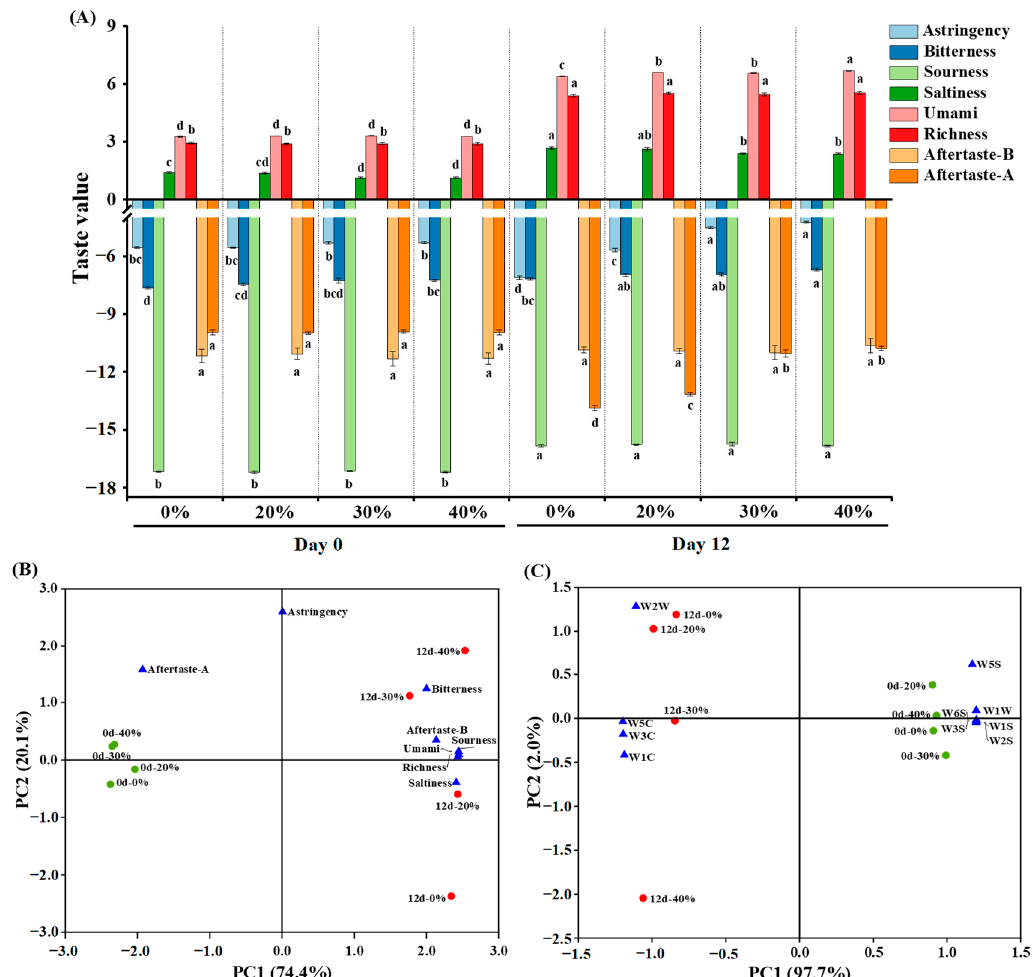
Figure 2. Taste assessment ( A ) and principal component analysis ( B ) based on the electronic tongue sensor responses, and principal component analysis ( C ) based on the electronic nose sensor responses of traditional dry sausage with different KCl substitution ratios at day 0 and day 12. a–d Means within the same taste attribute differ significantly among the different treatments ( p < 0.05). 0%: control dry sausage (2.50% NaCl); 20%: dry sausage with 20% KCl substituted for NaCl (2.00% NaCl + 0.50% KCl); 30%: dry sausage with 30% KCl substitution (1.75% NaCl + 0.75% KCl); 40%: dry sausage with 40% KCl substitution (1.50% NaCl + 1.00%